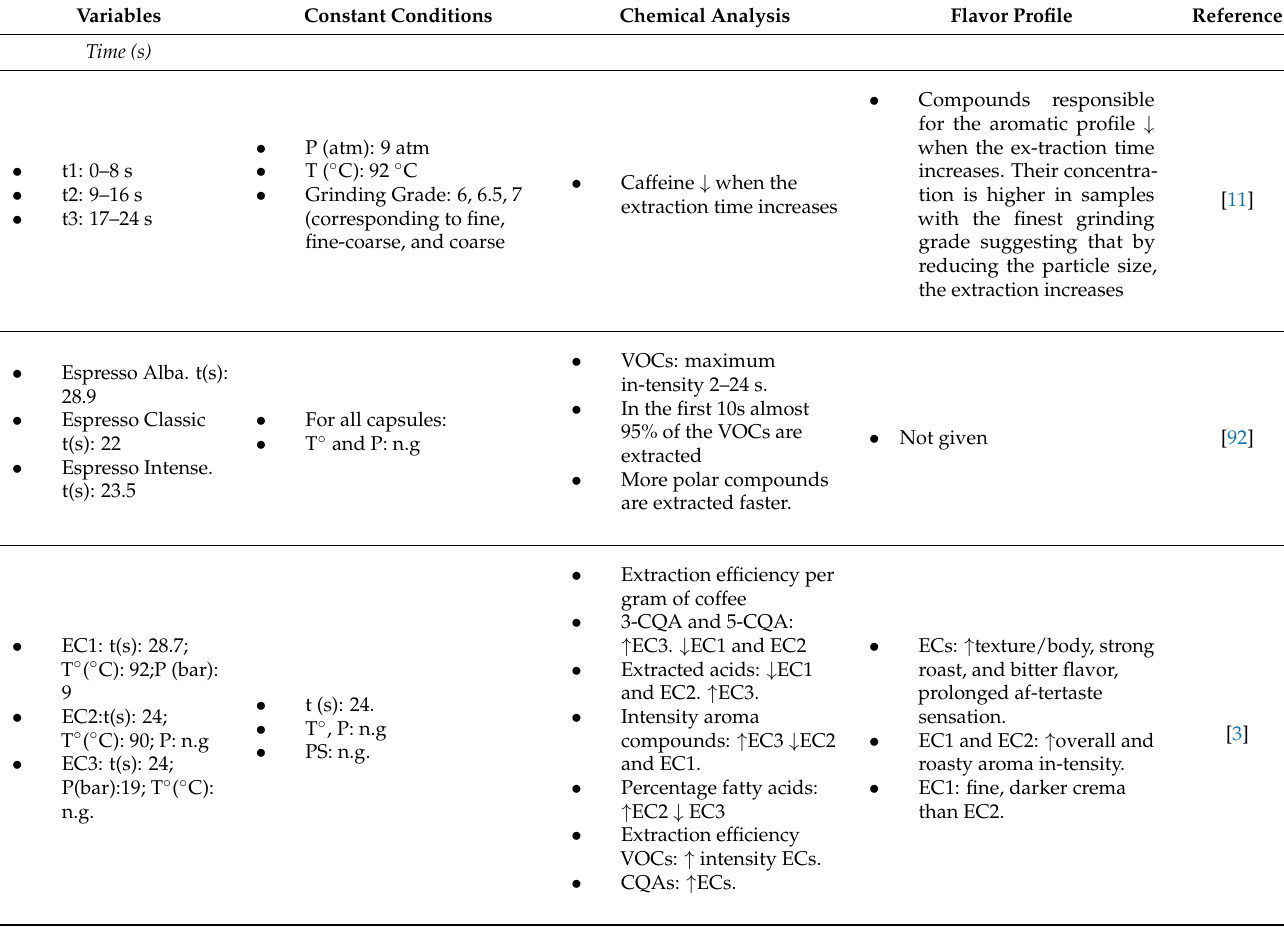
Table 3. Main variables that influence the extraction process and EC